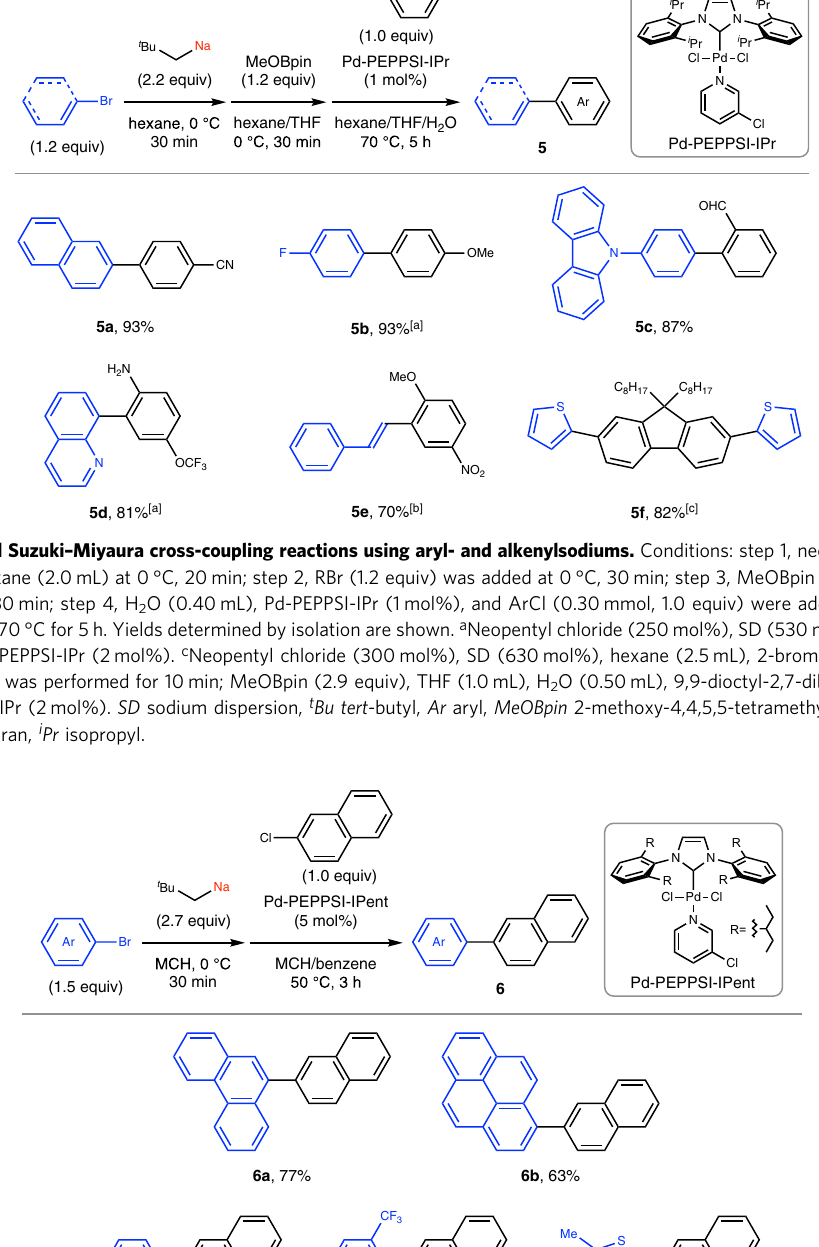
yields by using a Pd-PEPPSI-IPent catalyst in a solvent mixture of